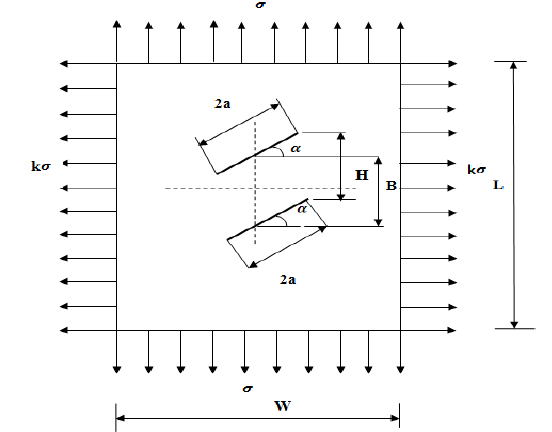
Figure 1: Specimen geometry of two non parallel central inclined cracks.